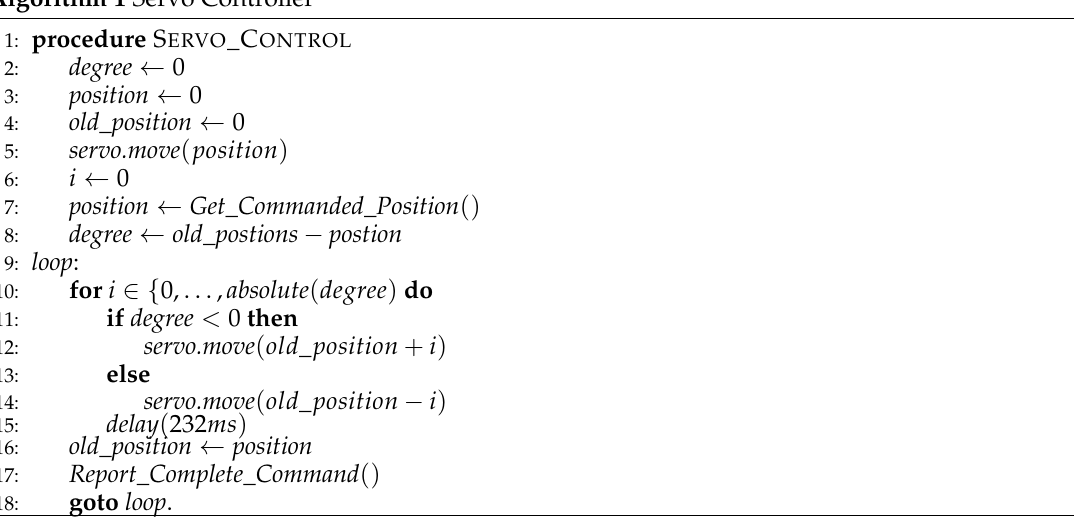
Algorithm 1 Servo